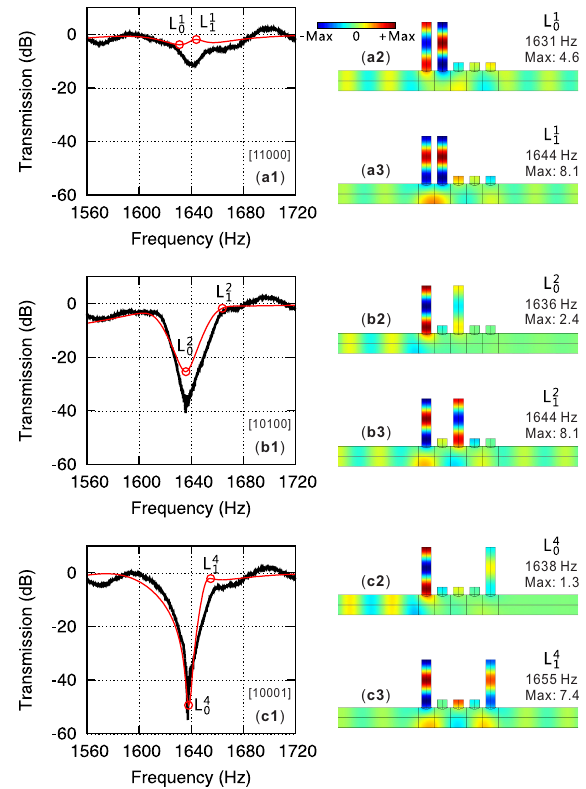
Figure 5. Transmission through a sequence of five short or long tubes grafted onto a waveguide with increasing separation between long tubes for ( a ) l = a ; ( b ) l = 2 a ; and ( c ) l = 4 a . Other dimensions are defined in Figure 1. Experimental (thick black line) and computed (thin red line) transmission spectra around the third resonance frequency of the long tube are shown on the left-hand side. Remarkable frequencies are labeled L α , with α = l / a indicating the normalized separation between the two long β tubes and β indicating either a transmission dip (0) or unit (1). Normalized pressure distributions at the remarkable frequencies are shown on the right-hand side. For simplicity, we only display vertical cross-sections going through the symmetry axis of the waveguide. In each case, the frequency of the incident harmonic guided waves is shown on top. The color scale is for pressure normalized with respect to the maximum pressure